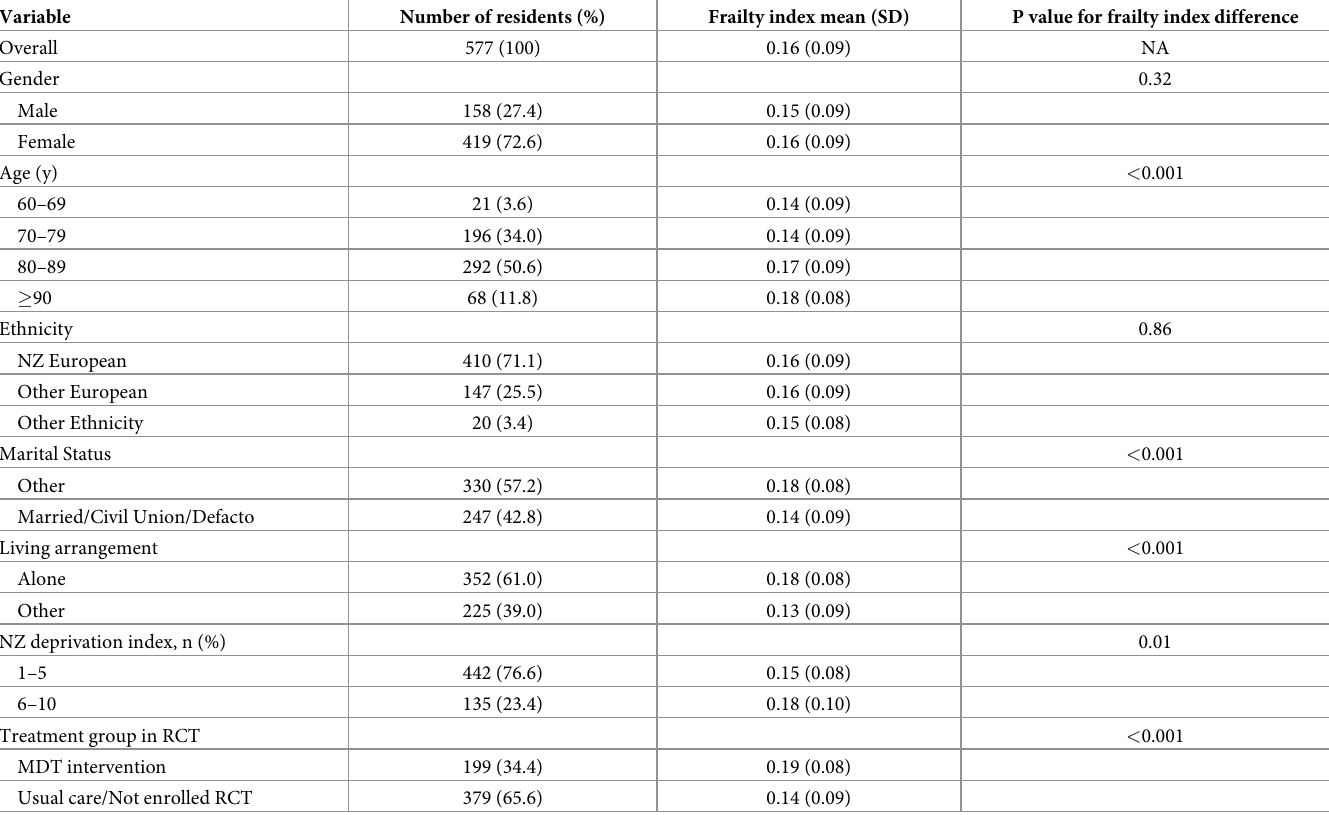
Table 1. Mean frailty index by baseline sociodemographic